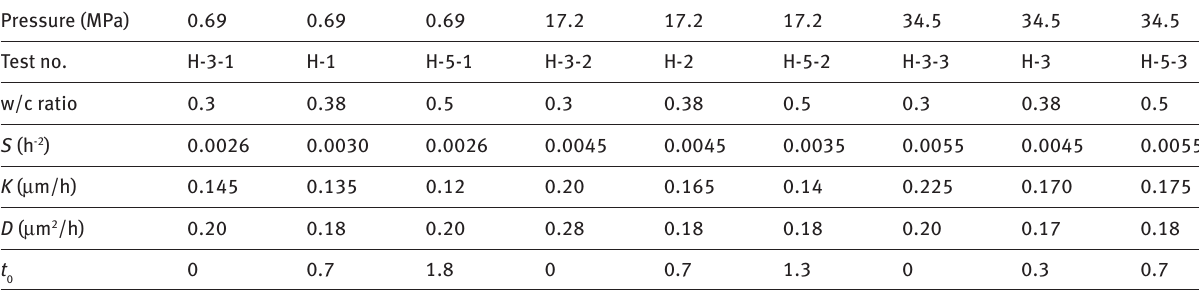
Table 5: Fitted model parameters for different w/c ratios and curing pressures (Class H cement) cured at room temperature. Pressure (MPa) 0.69